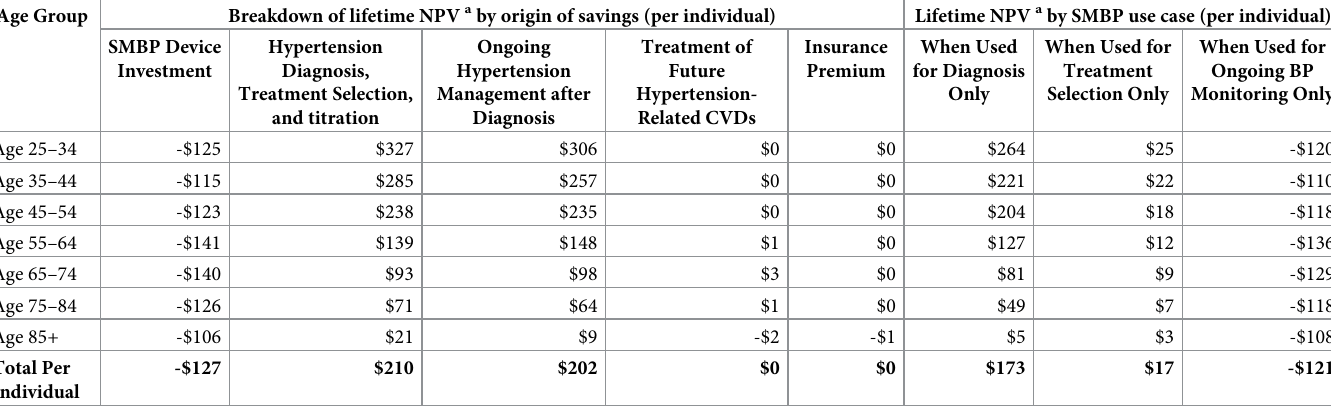
Table 2. Financial impact of SMBP by origin of savings and by use case (hypertension diagnosis only, treatment selection and titration only, or management only). Age Group Breakdown of lifetime NPV a by origin of savings (per individual) Lifetime NPV a by SMBP use case (per individual)